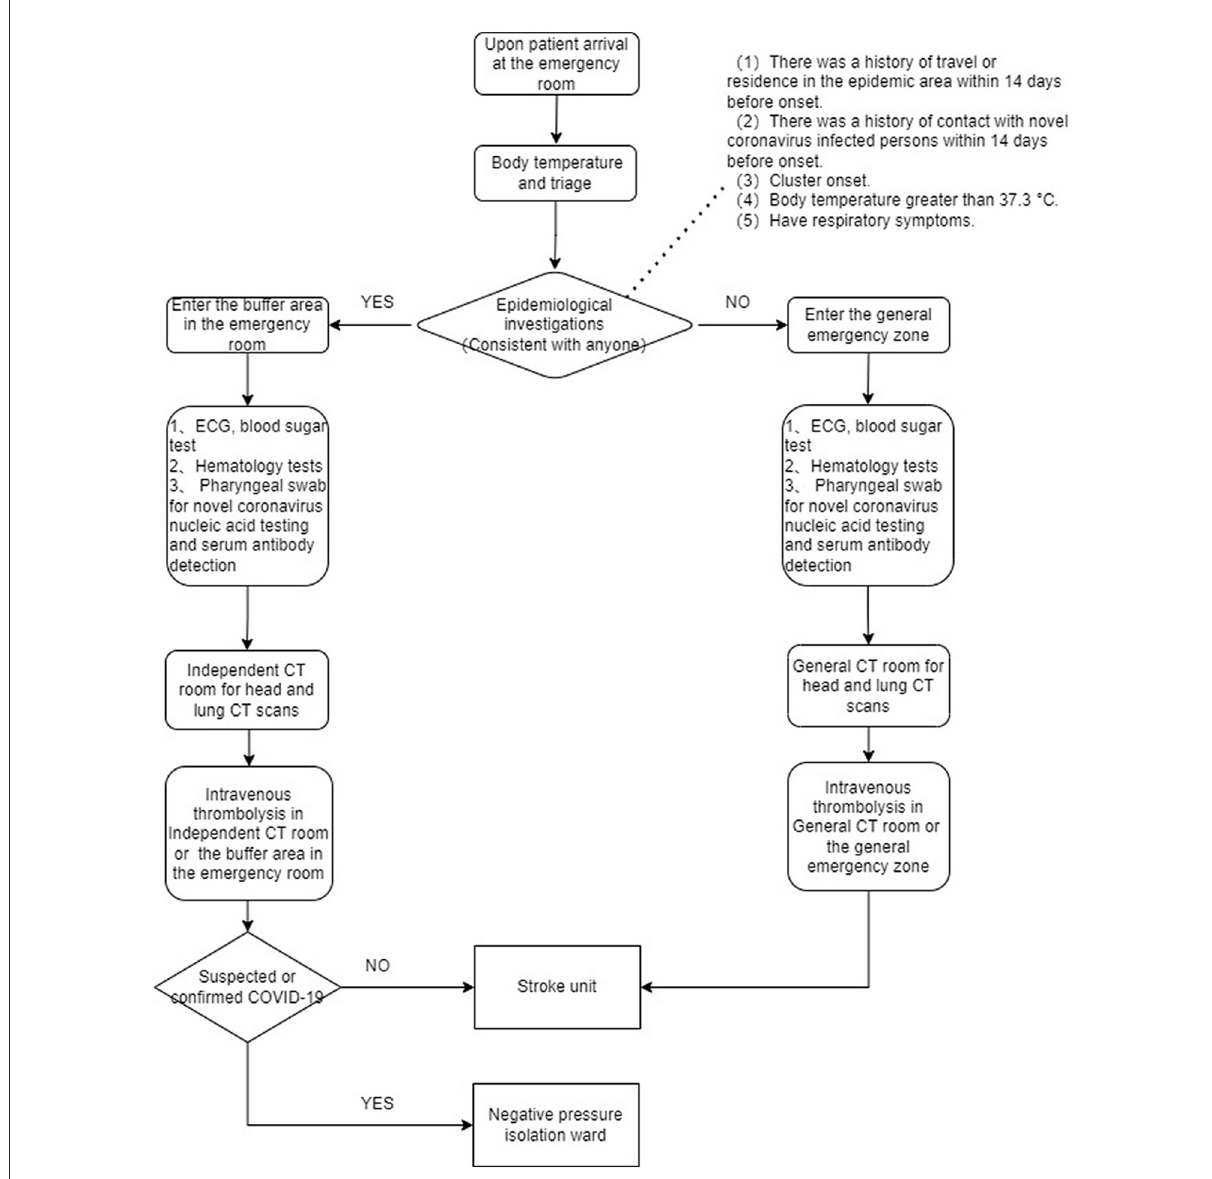
FIGURE1 The improved process of the emergency stroke green channel after the pandemic